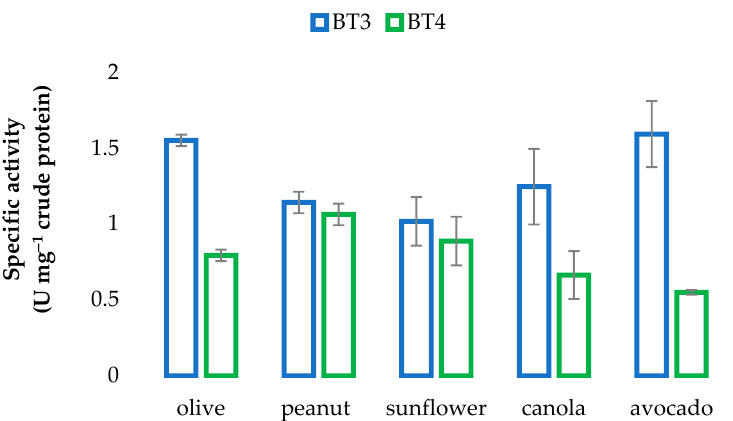
Figure 4. Comparision of enzyme actitivies of Streptomyces sp. BT3 and Streptomyces sp. BT4 determined after growth on a variety of oil-containing media. Error bars represent standard deviation from the mean ( n = 3).